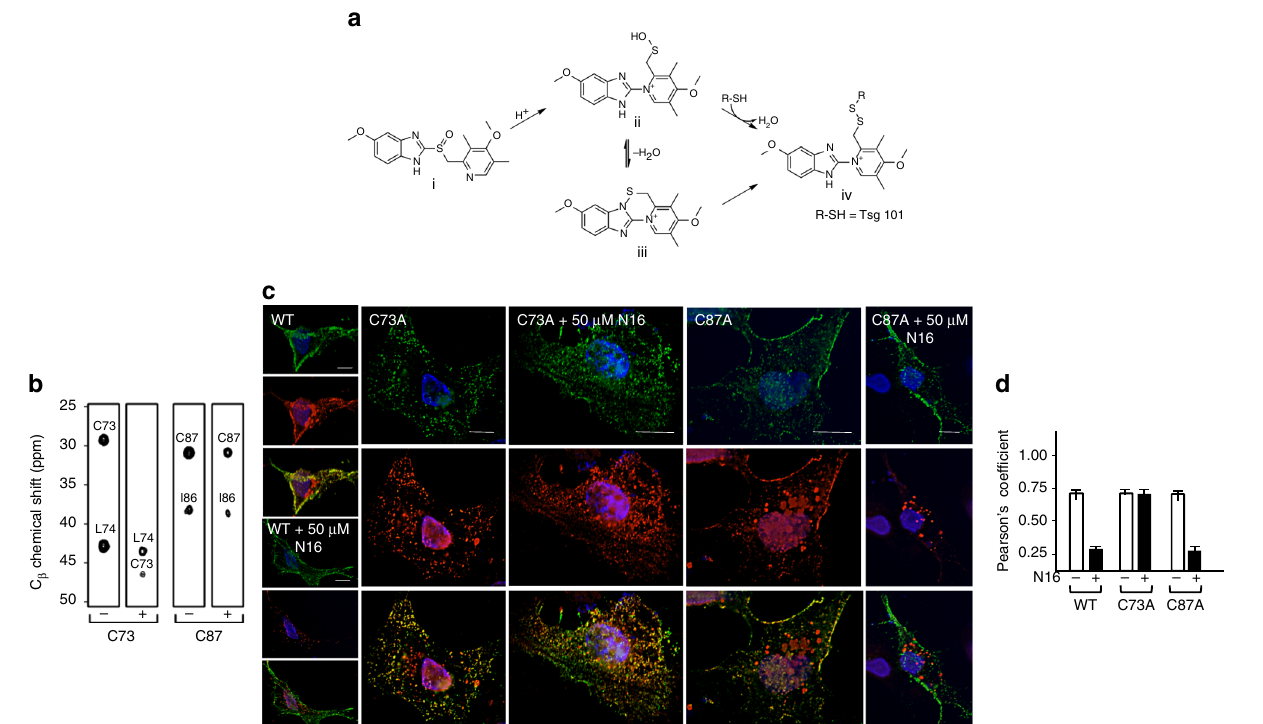
Fig. 5 N16 binds covalently to C73 in the Tsg101 UEV domain. a Activation of N16 to reactive sulfenamide. N16 (i) is converted to intermediates sulfenic acid (ii) and sulfenamide (iii) through acid catalysis to yield a covalently attached N16-Tsg101 UEV complex (iv). b HNCACB C β regions for residues C73, L74, I86, and C87 of Tsg101 without ( − ) and with (+) N16 (1:1 ratio with Tsg101 UEV). c Examination by fl uorescence microscopy of cells co-expressing Gag WT -GFP and Tsg101 WT -Myc, Tsg101 C73A -Myc or Tsg101 C87A -Myc in the absence and presence of 50 μ M N16. Scale bars = 10 microns. n = 3. d Pearson ’ s coef fi cient of correlation values; error bars represent 1 SD for the coef fi cient